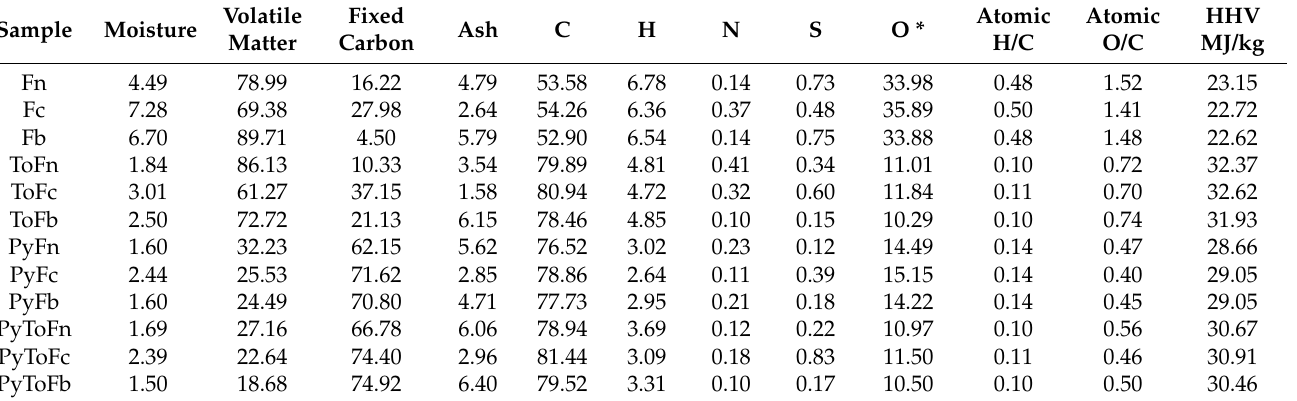
Table 1. Proximate (±3% associated error) and ultimate (±5% associated error) analysis (wt%, moisture free basis) of needles, cones and barks from silver fir and of their solids from torrefaction and/or pyrolysis, as well as the related calculated parameters.